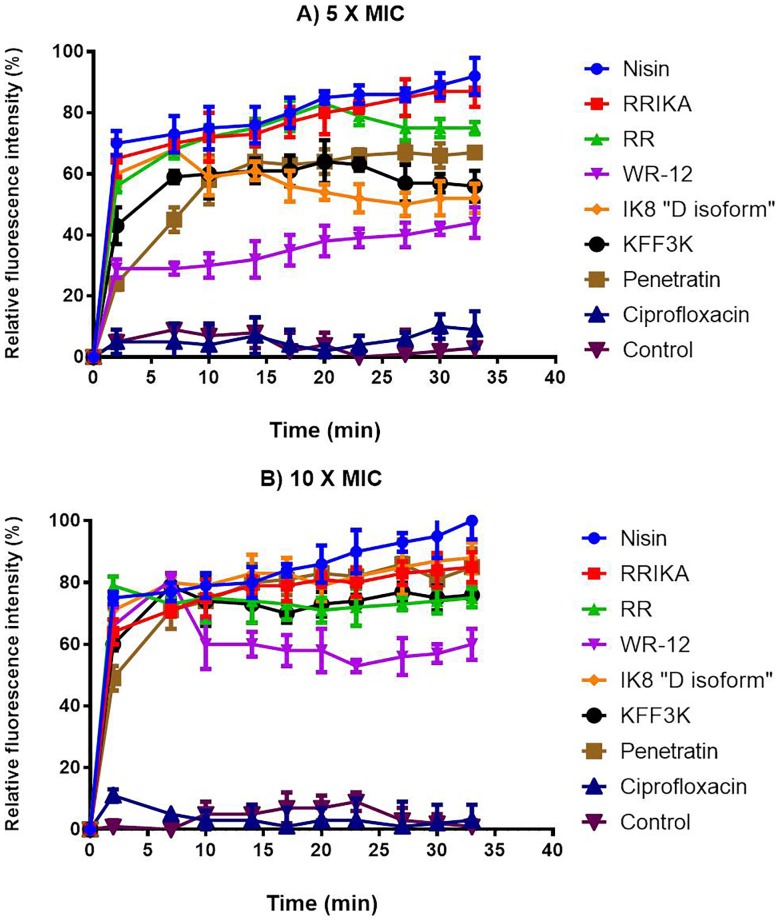
Permeabilization of the cytoplasmic membrane of SP3 as a function of peptide concentration at 5X MIC (A) and 10 X MIC (B), indicated by percent of propidium iodide fluorescence.Each experiment was done in triplicate, and the values represent means ± standard deviations.